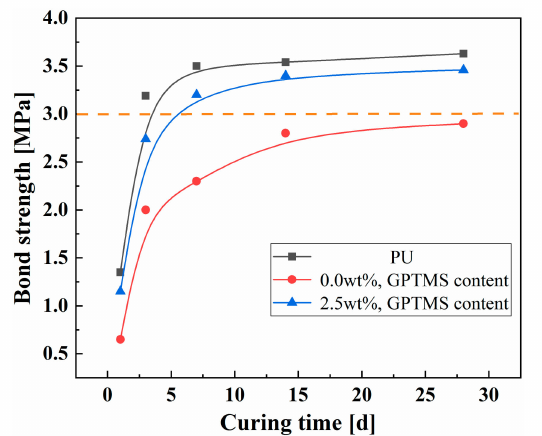
Figure 7. Bond strengths of PU, PU / MFA-0.0 wt. %, and PU / MFA-2.5 wt. % specimens at di ff erent curing